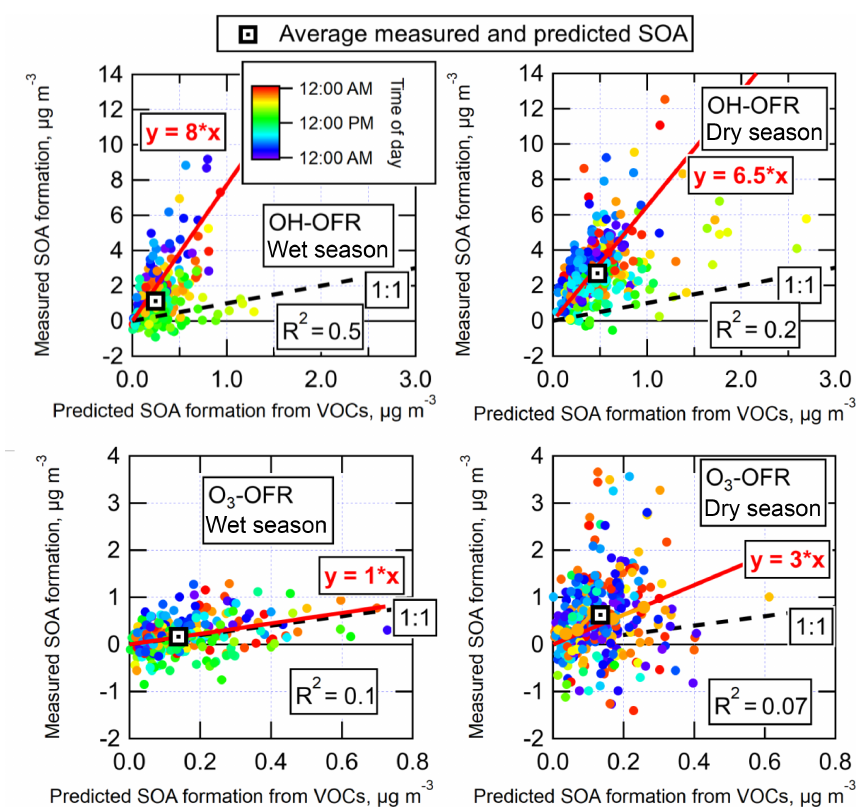
Figure 8. Measured SOA formation vs. the concentration of SOA predicted to form from the oxidation of ambient VOCs, shown for OH and O 3 oxidation during both wet and dry seasons. Regression lines, correlation coefficients, and average measured and predicted SOA are shown for each OFR type and season. Standard errors of the mean of all average measured and predicted SOA values were smaller than the size of the marker and are thus not shown. Data are colored by local time of day. Measured SOA formation is corrected for LVOC fate.